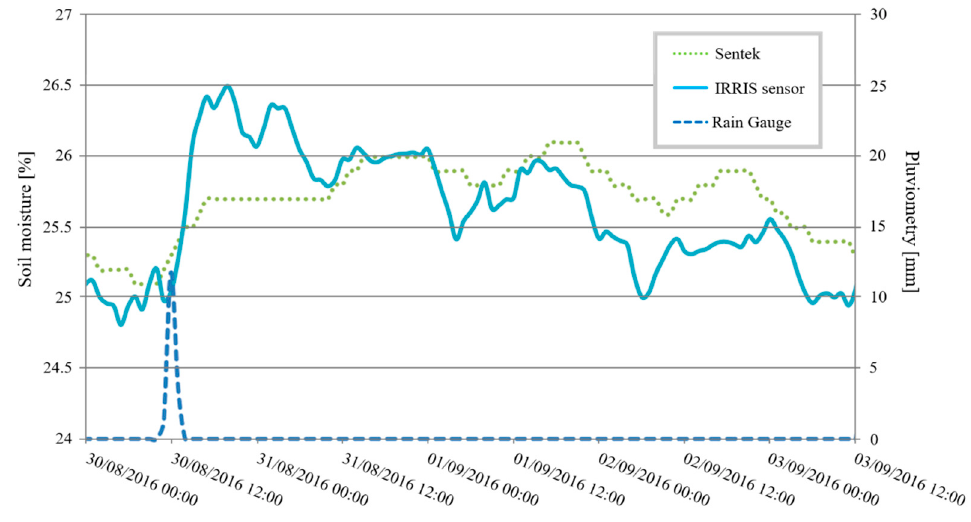
Figure 35. Comparison of the Sentek and IRRIS sensors in a cornfield.